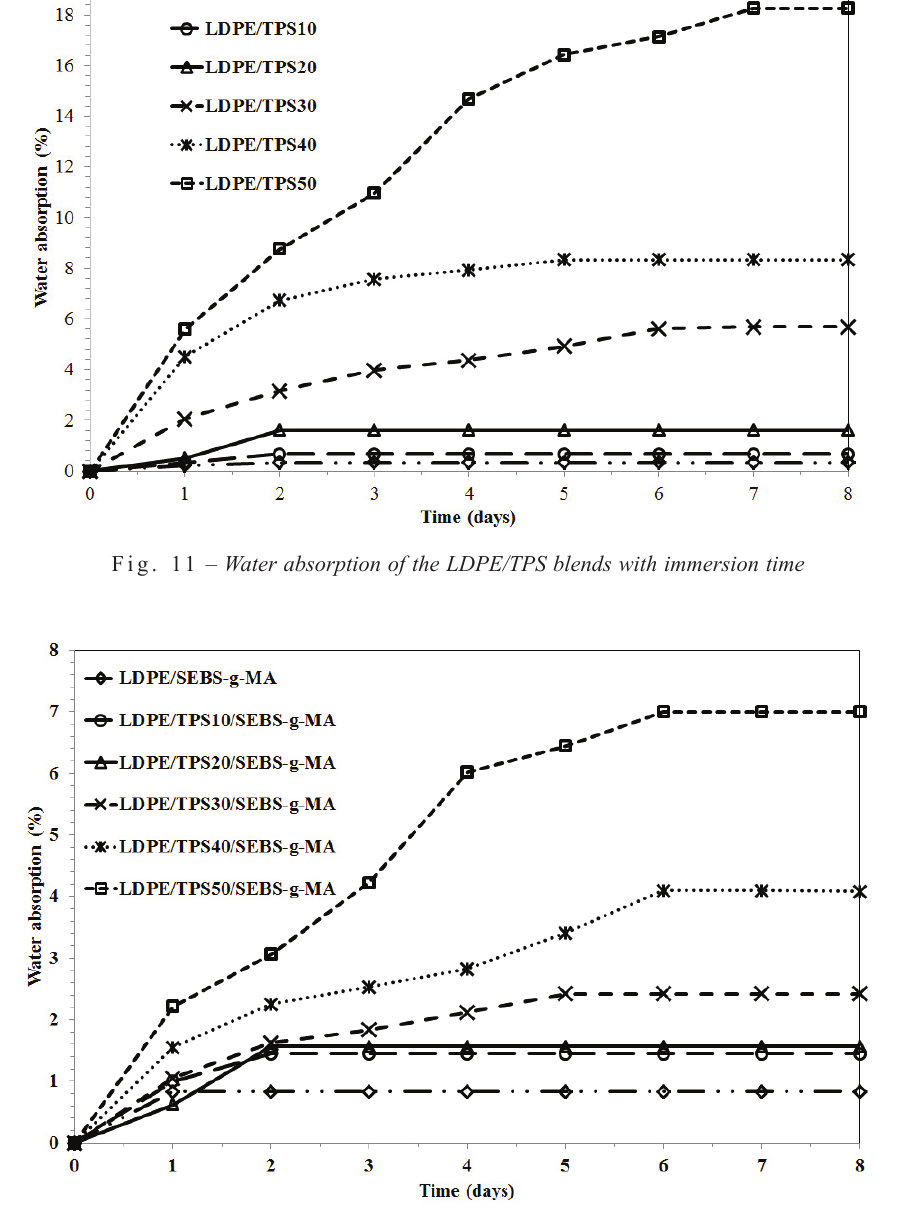
Fig. 12 – Water absorption of the LDPE/TPS/SEBS-g-MA blends with immersion